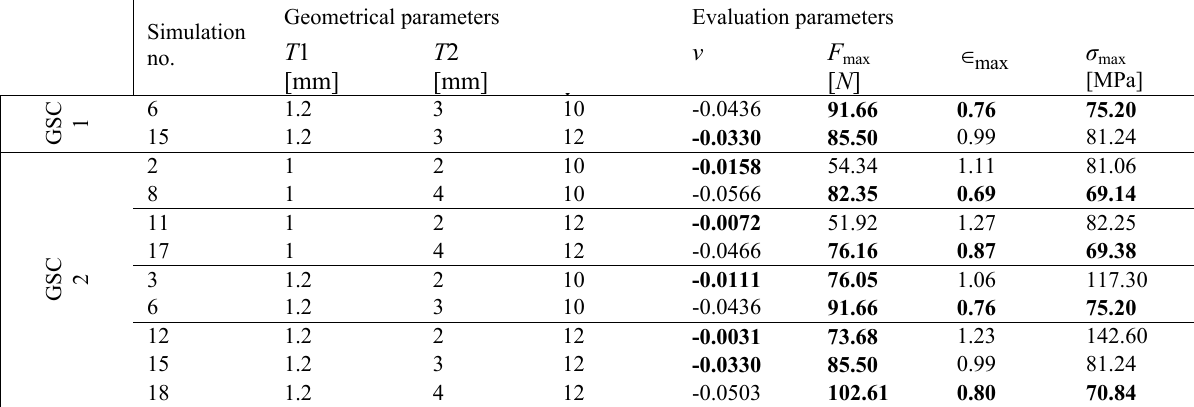
Table 6. Generalized systems of contradiction (GSC) Geometrical parameters Evaluation parameters Simulation